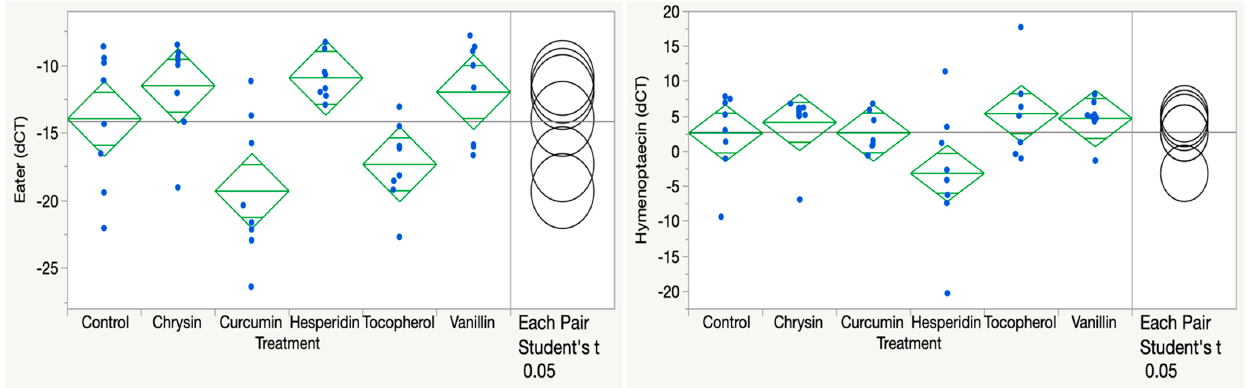
Figure 2. Analysis of honey bee immune genes by treatment. Normalized Δ Cq values of two honey bee immune genes, eater and hymenoptaecin. Cup study, 8 replicates/cup per treatment or control. The control is sugar water. Treatments were supplemented with sugar water at 100 ppm. A larger value indicates a higher expression of the honey bee gene. The diamond tips represent the 95% confidence intervals for the ANOVA, with the mean designated with the middle horizontal line across each diamond. Comparison circles shown means, where circles that overlap are not significantly different, whereas circles that do not overlap are significantly different.